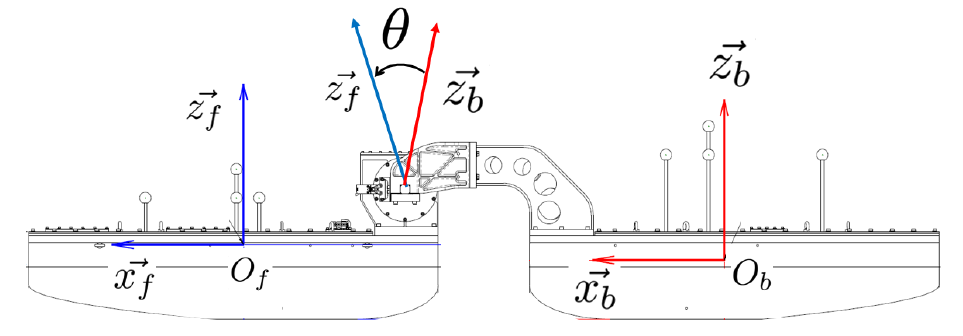
Figure 1. CAD view of the raft model. The front floater, facing the waves, is on the left. The θ angle is defined as the relative pitch motions of the two